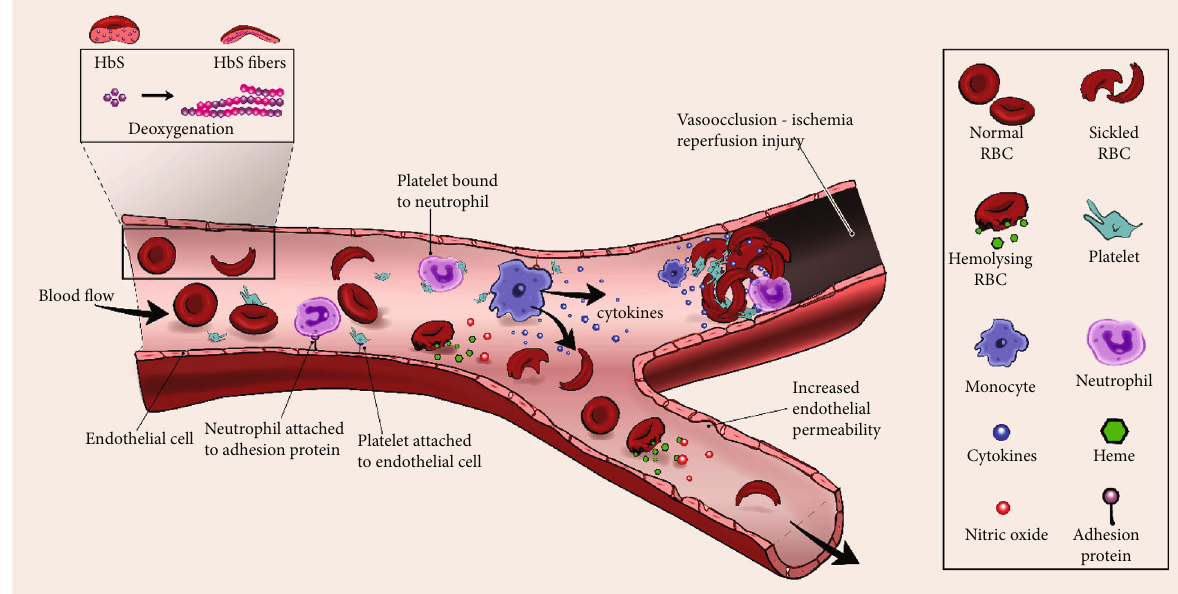
Figure 2: Pathophysiologic mechanisms of sickle cell disease. Deoxygenation leads to polymerization of HbS and deformation of RBCs to a sickle shape, making them less fl exible. Broadly, RBC, leucocyte, and platelet adhesion are enhanced, and cell-to-cell and cell-to-endothelial interactions occur; there is an upregulation of adhesion proteins (ICAM-1, VCAM-1, P-selectin, and E-selectin); and damage and activation of the endothelium occur. RBC hemolysis releases heme and arginase which scavenge nitric oxide, and stimulates the release of adhesion proteins. Activated platelets cause neutrophils to form neutrophil extracellular traps (NETs), which induce platelet and RBC aggregation; interact with sickled RBCs, neutrophils, and monocytes. Neutrophils also adhere to the endothelium through interaction with adhesion proteins. Monocytes release cytokines, platelet-activating factor, and express tissue factor which upregulate endothelial adhesion proteins, activate platelets, and kickstart the coagulation cascade. Accumulation of leukocytes, platelets, and RBCs with coagulation pathway activation through various mediators leads to the formation of thrombi which are responsible for vaso-occlusion. These events subsequently cause local ischemia and reperfusion injury which leads to organ